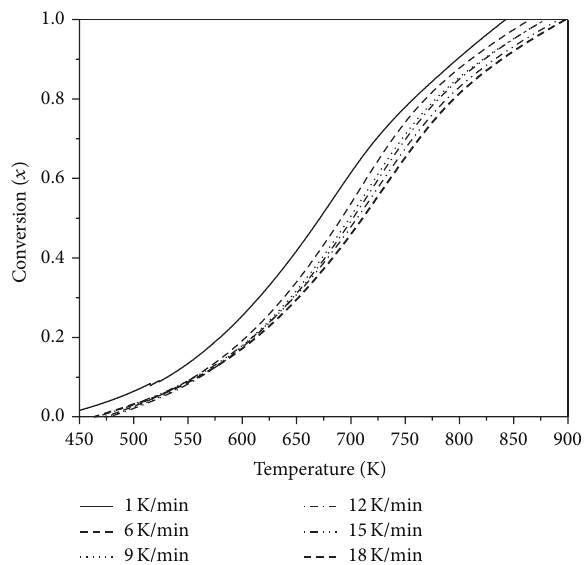
Figure 3: Conversion curves for different heating rates for pyrolysis of lignite coal under N 2 atmosphere.